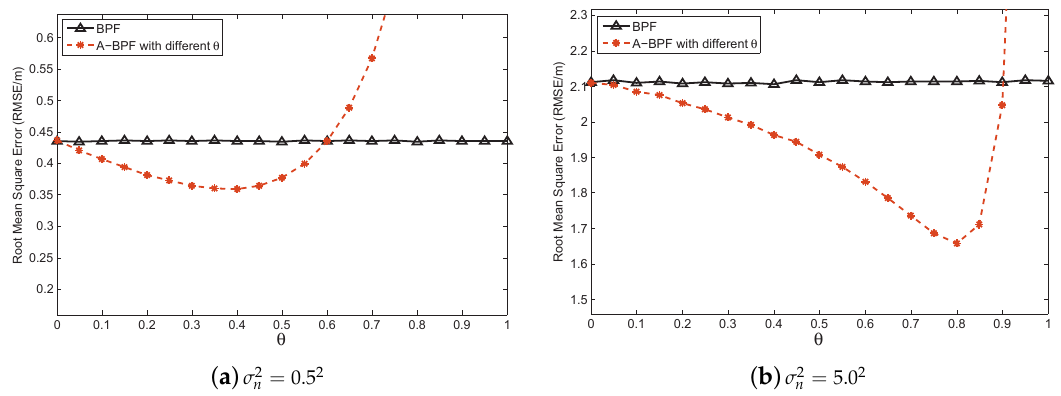
Figure 7. Estimation error comparison for different algorithms with different measurement error